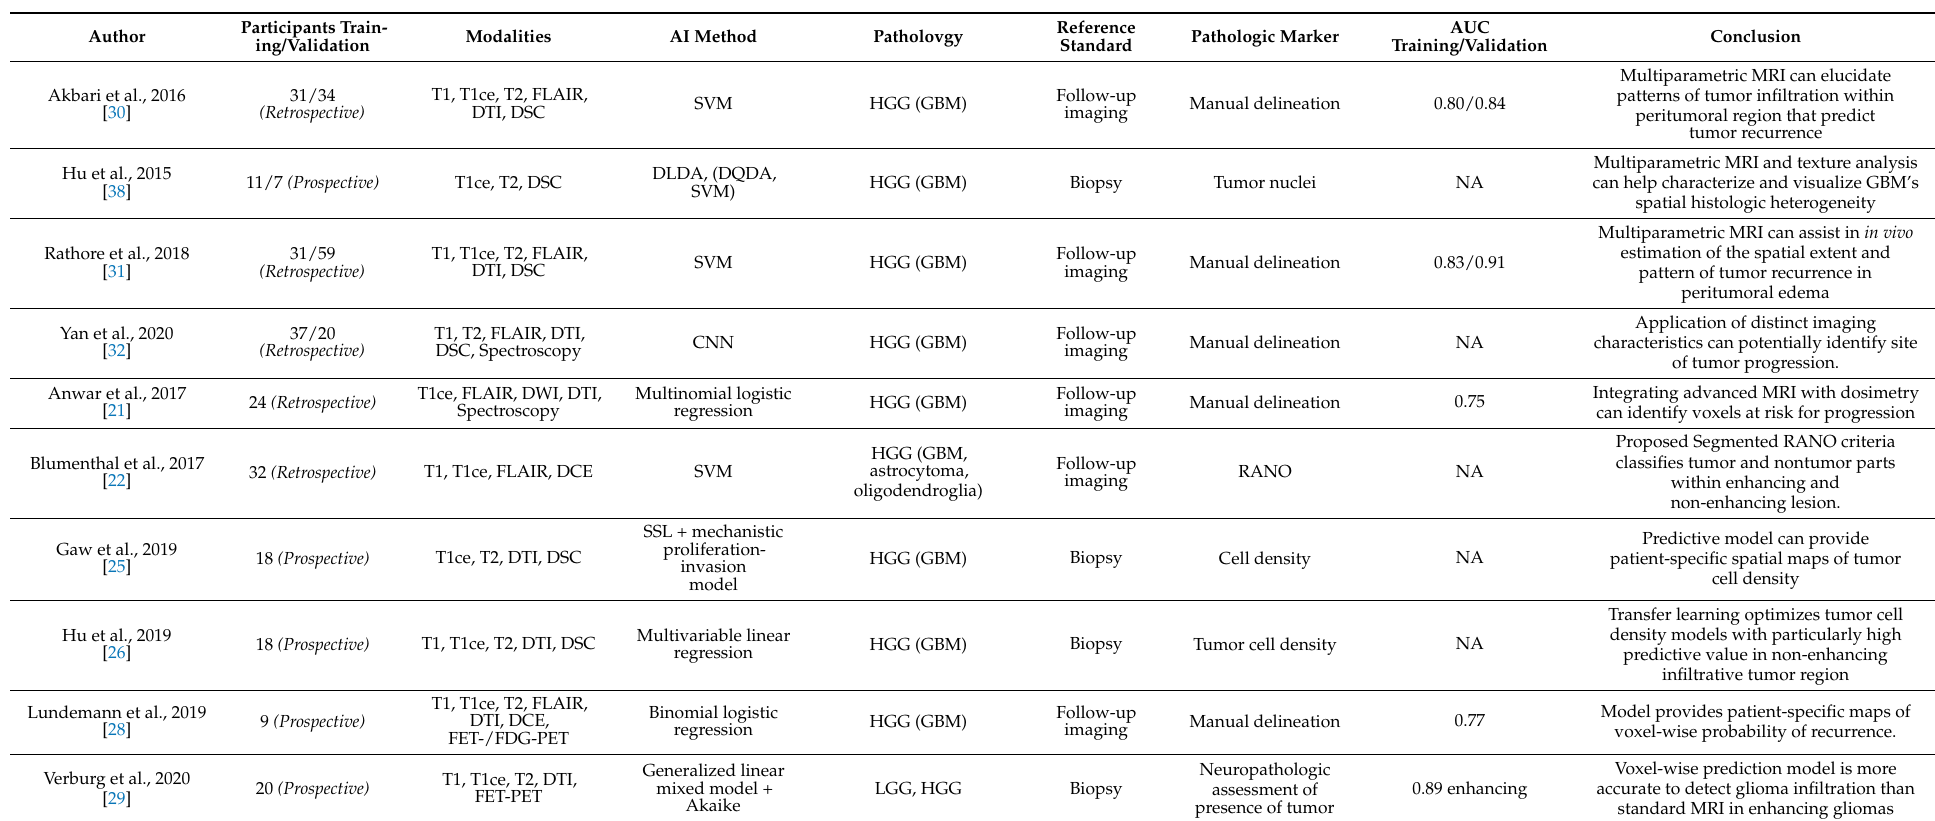
Table 1. Results from all 14 included